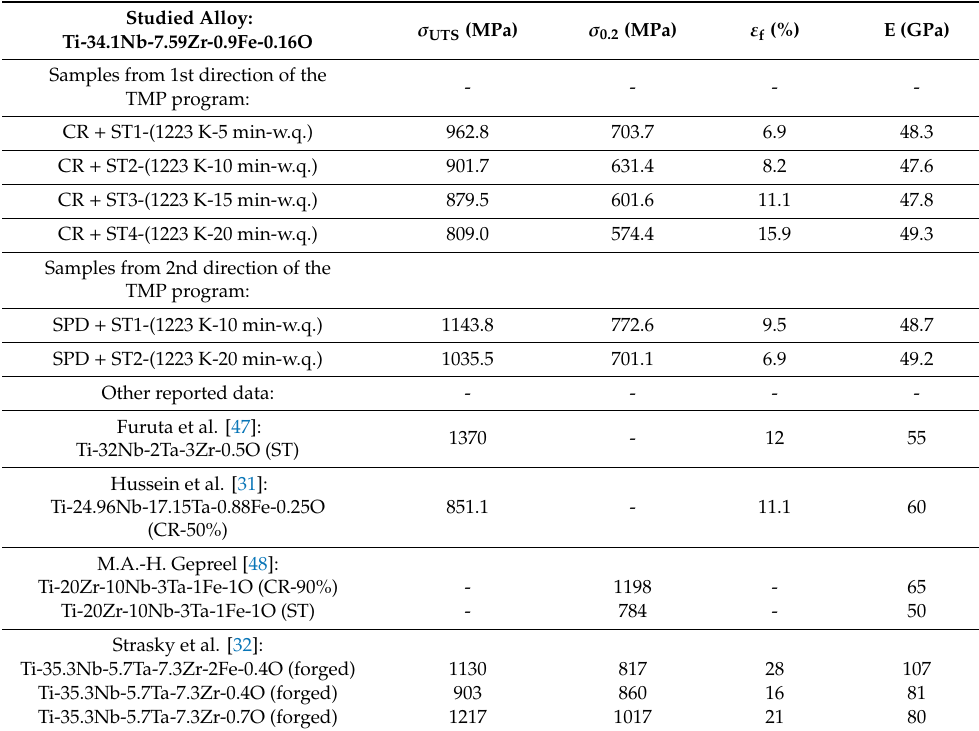
Table 4. Mechanical properties of the studied alloy and those of other similar